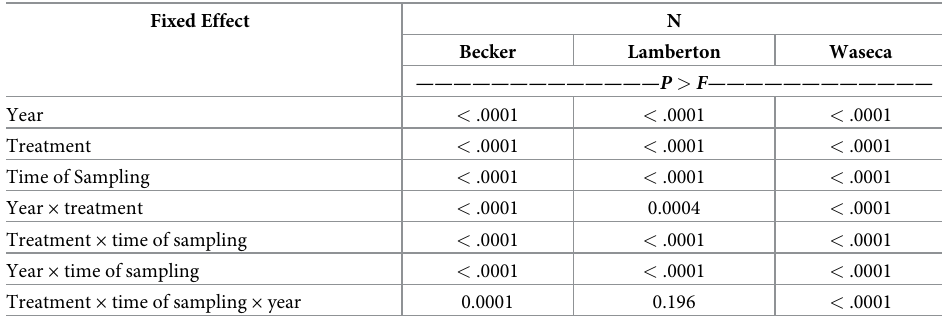
Table 3. Tests of fixed effects on maize nitrogen uptake.